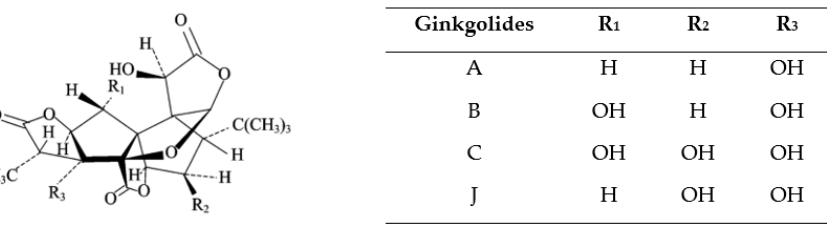
Figure 2. Chemical structure of ginkgolides A, B, C, and J (Adapted from [61]).